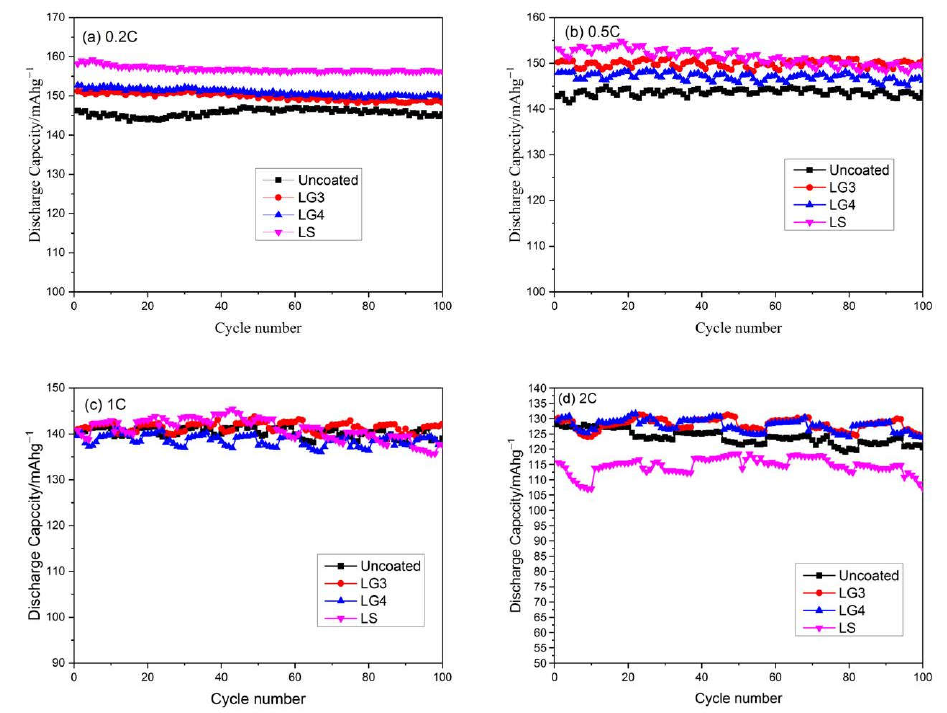
Figure 11. The cyclic performance curves of assembled lithium batteries at different discharge rates. Table 6. The data of discharge capacity and capacity retention rate of assembled lithium batteries at different discharge rates.